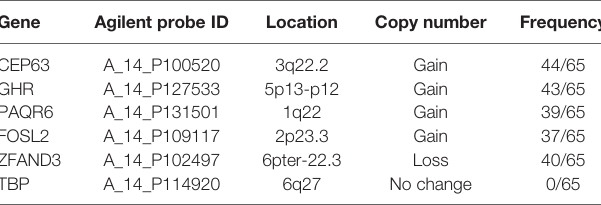
TABLE 3 | Candidate genes selected from array CGH pro fi ling for